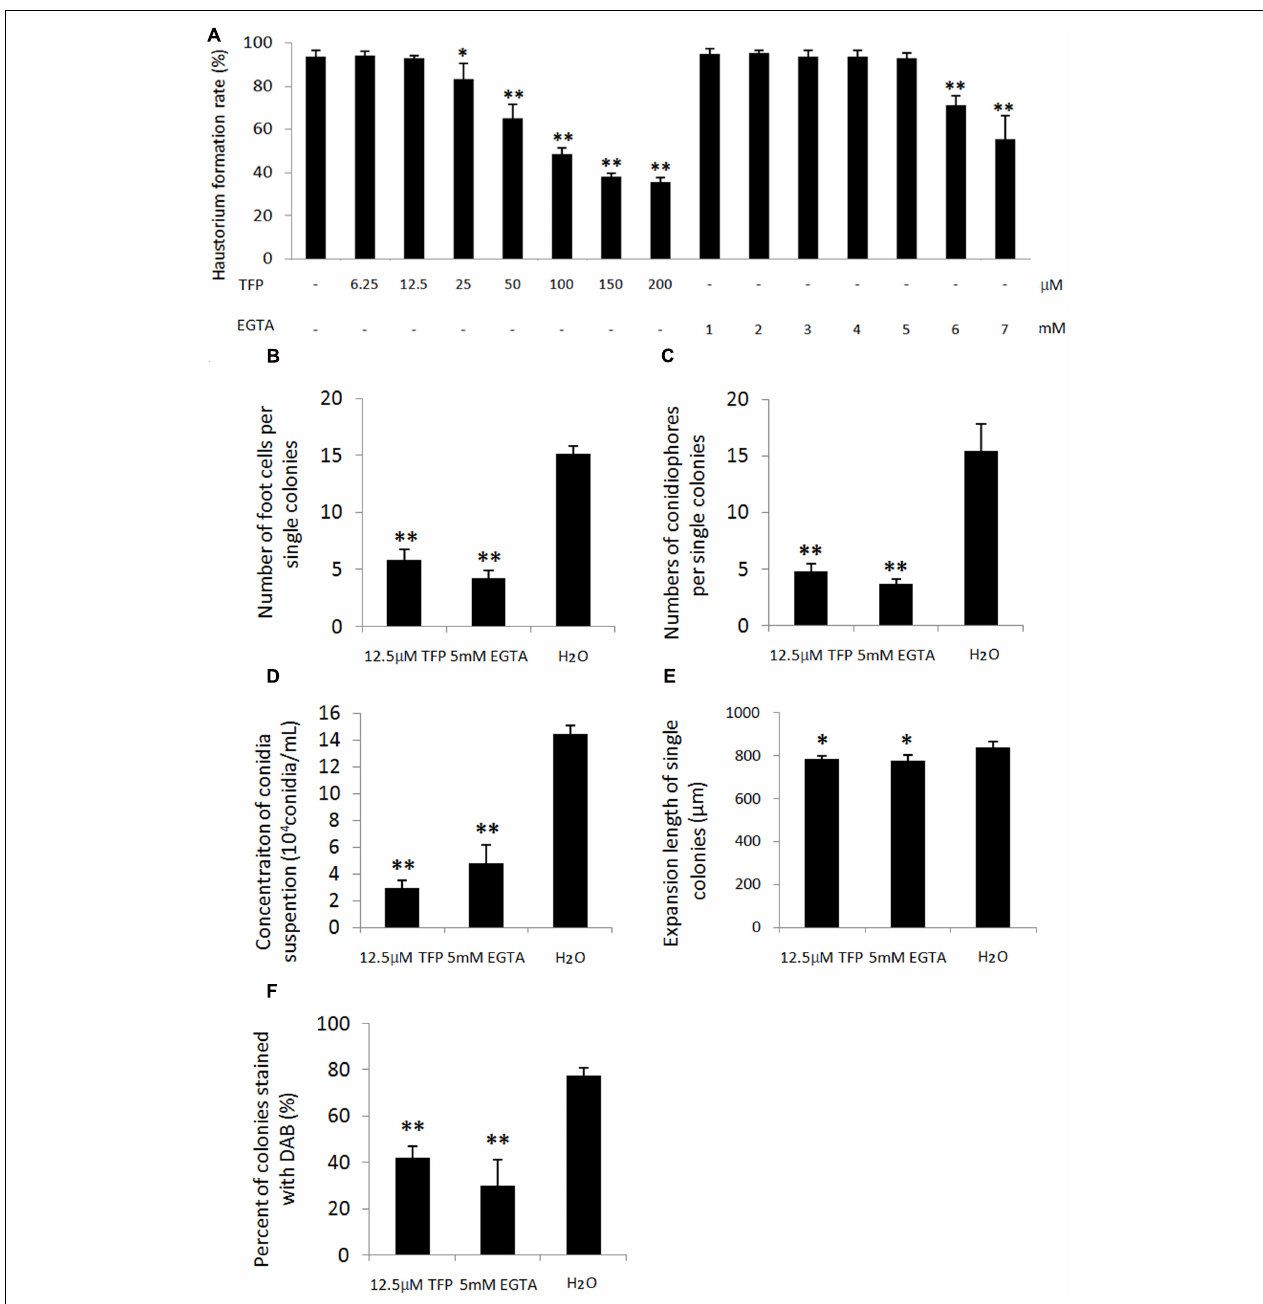
FIGURE 7 | Effect of 5 mM EGTA and 12.5 µ M trifluoperazine dihydrochloride (TFP) on conidiation and H 2 O 2 accumulation during conidiation of Bgt . Wheat leaf segments of Chancellor were inoculated with isolate 21-2. A pilot experiment with a series concentration of two chemicals (dissolved in 0.025% Tween 20) was carried out by spraying at 1 dpi and the haustorium formation rates were investigated at 3 dpi (A) . Based on these data, 5 mM EGTA and 12.5 µ M TFP were applied at 4 dpi by spraying the solutions. Infected leaf segments were sampled at 5 and 6 dpi and stained with the trypan blue and DAB solution. Next, a microscopy observation was carried out. Number of foot cells per single colonies at 5 dpi (B) , number of conidiophores per single colonies at 6 dpi (C) , conidia concentration of 2.5 mL conidiospore suspension dislodged from 2.5 cm long diseased leaf segments at 10 dpi (D) , mycelium expansion width of single colonies at 100 × magnification at 5 dpi (E) and percentage of colonies with DAB stained conidiophore(s) at 5 dpi (F) were investigated with three replicates. For each replicate, 30 colonies were observed. All the experiments were performed two times with similar results. Data from another independent experiment are presented in Supplementary Figure S8. Values are means of data with three replicates of each treatment and error bars indicate standard error of the means. The significance of the differences between the treatments and untreated control was determined by Student’s t -tests. Significant decreases in the rates of foot cell and conidiophore formation and conidia production after 5 mM EGTA and 12.5 µ M TFP treatment occurred ( ∗∗ p < 0.01). Both treatments have a slight impact on the mycelium growth ( ∗ p < 0.05).